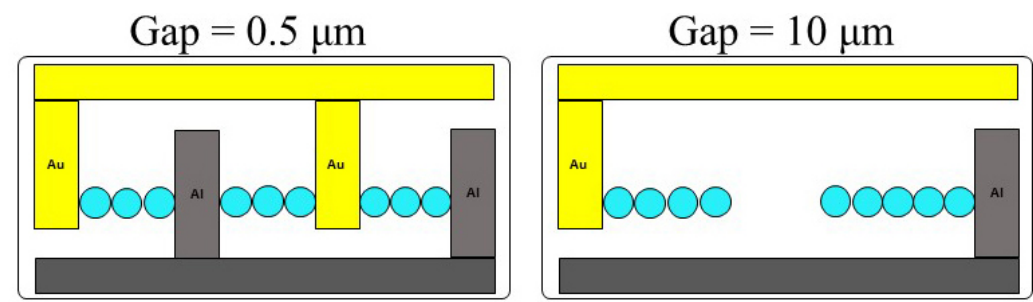
Figure 5. Schematic diagram showing the probable reason for the difference in the current response time for sensors with two different gaps between the electrodes.